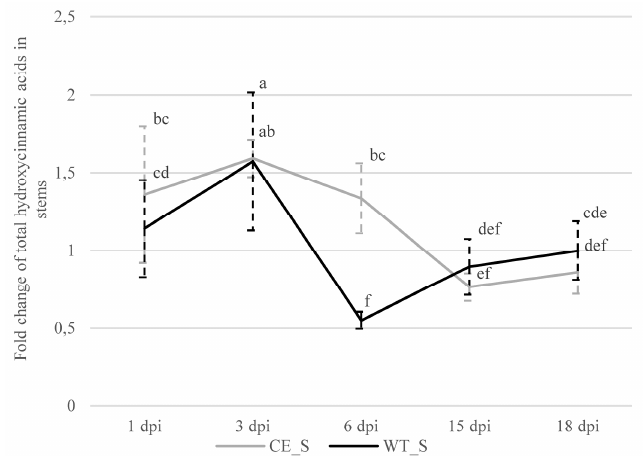
Figure 5. Fold changes (infected / control) of total analyzed hydroxycinnamic acids in the stems (S) of susceptible (CE; Celeia) and resistant (WT; Wye Target) hop cultivars. Data are presented as mean ± SD. Values below 1 indicate decreases in content compared to the control. Data were analyzed by one-way ANOVA and Duncan’s post hoc test. Different letters denote statistically significant differences at p ≤ 0.05.